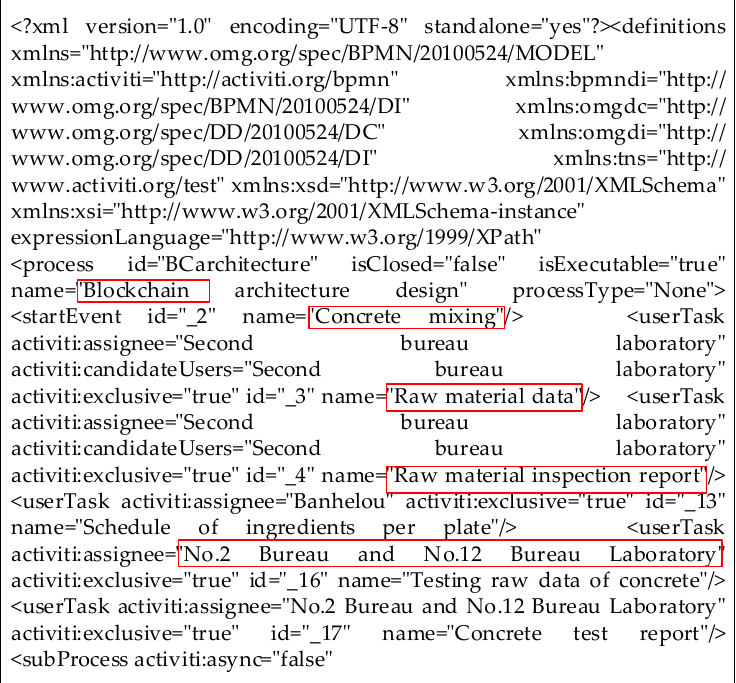
Figure 6. Business xml format.